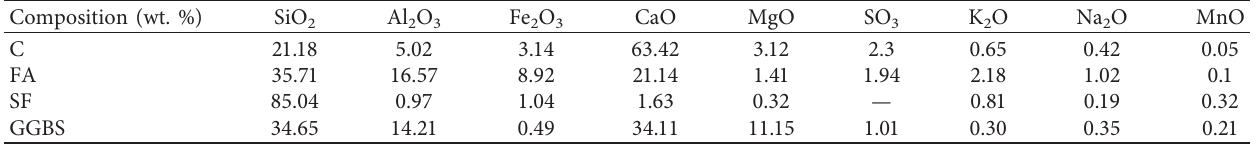
Table 1: Chemical composition of cementitious materials.